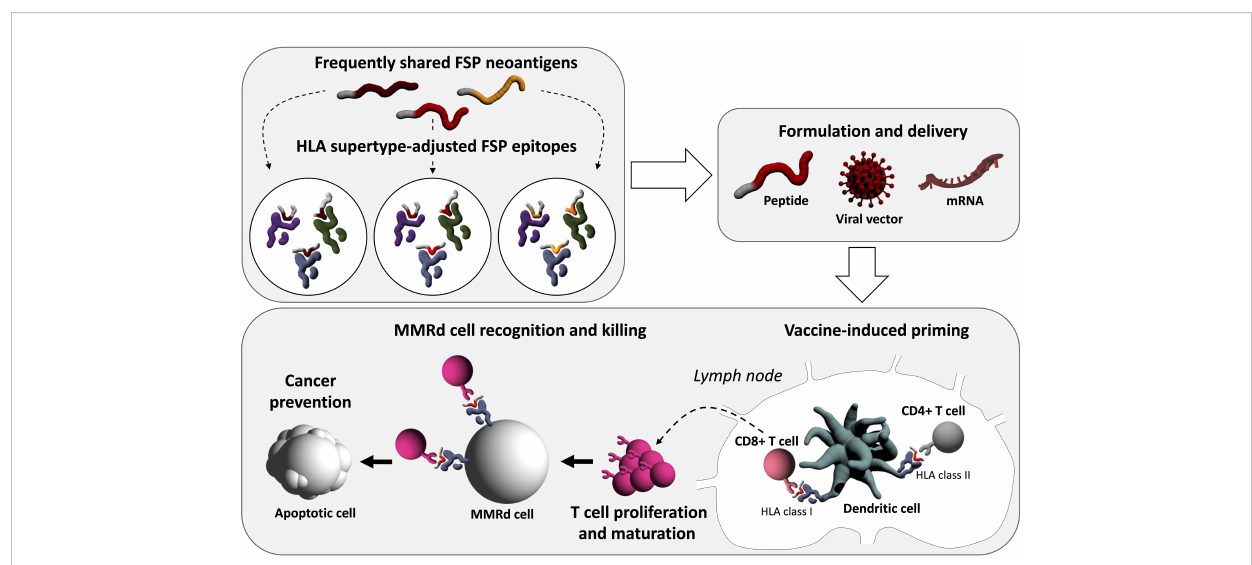
FIGURE 2 Conceptual illustration of next-generation FSP preventive cancer vaccines. After the selection of immunogenic FSP frequently shared among MMRd cells, FSP epitopes can be HLA supertype-adjusted, facilitating higher vaccine effectiveness. Vaccine delivery can be pursued, among others, with different approaches including peptide, viral vector-based, or mRNA technology. Immunologically, the fi rst step will be vaccine-induced priming, during which the delivered neoantigens encounter antigen-presenting cells, most importantly dendritic cells at the injection site. Neoantigen-loaded dendritic cells traf fi c to lymph nodes which are primary sites of T cell priming. There, vaccine-derived antigens on HLA class I and II molecules are presented to CD8 + and CD4 + T cells. Activated T cells proliferate and mature into effector T cells which leave the lymph nodes entering the periphery. Ideally, neoantigen-speci fi c CD8 + T cells can induce apoptosis in MMRd cells, which present the respective antigen on HLA class I molecules, and thereby prevent